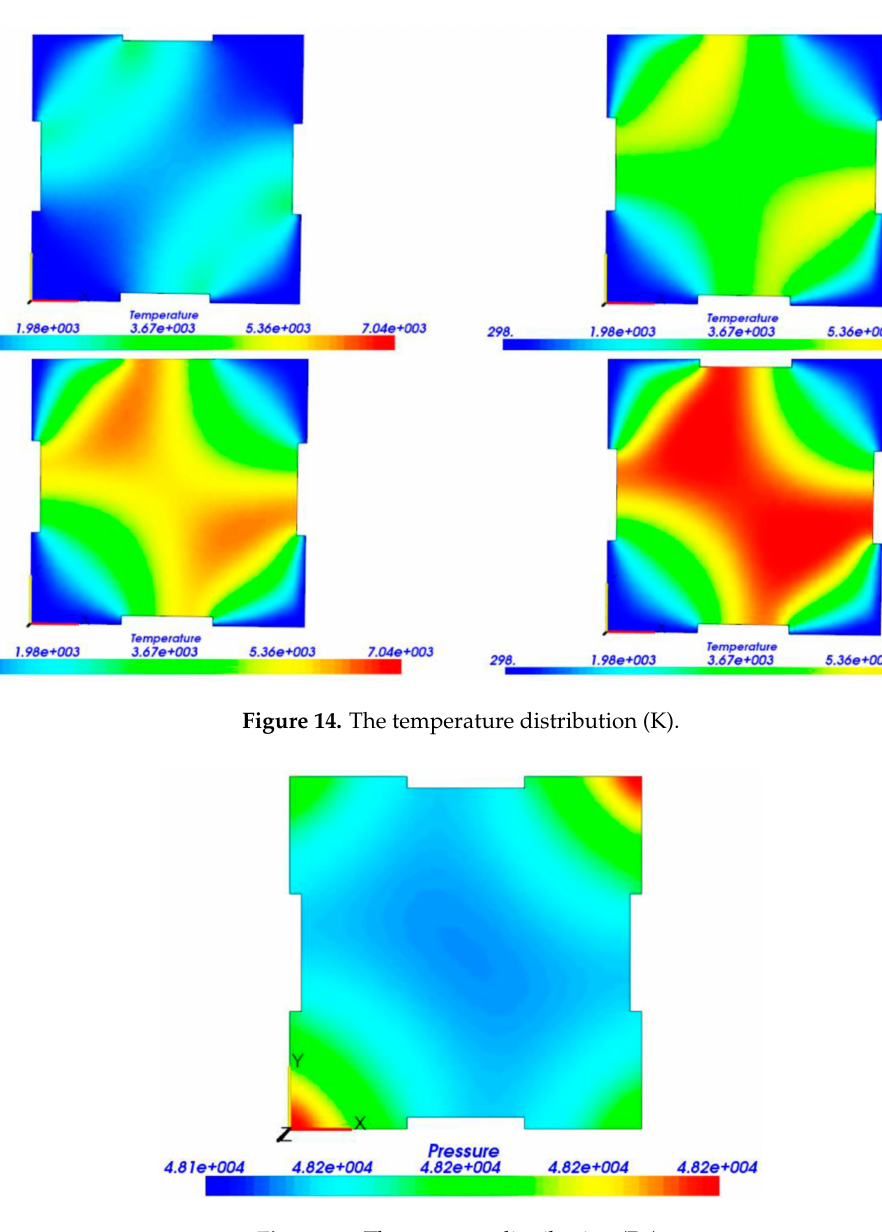
Figure 15. The pressure distribution (Pa).